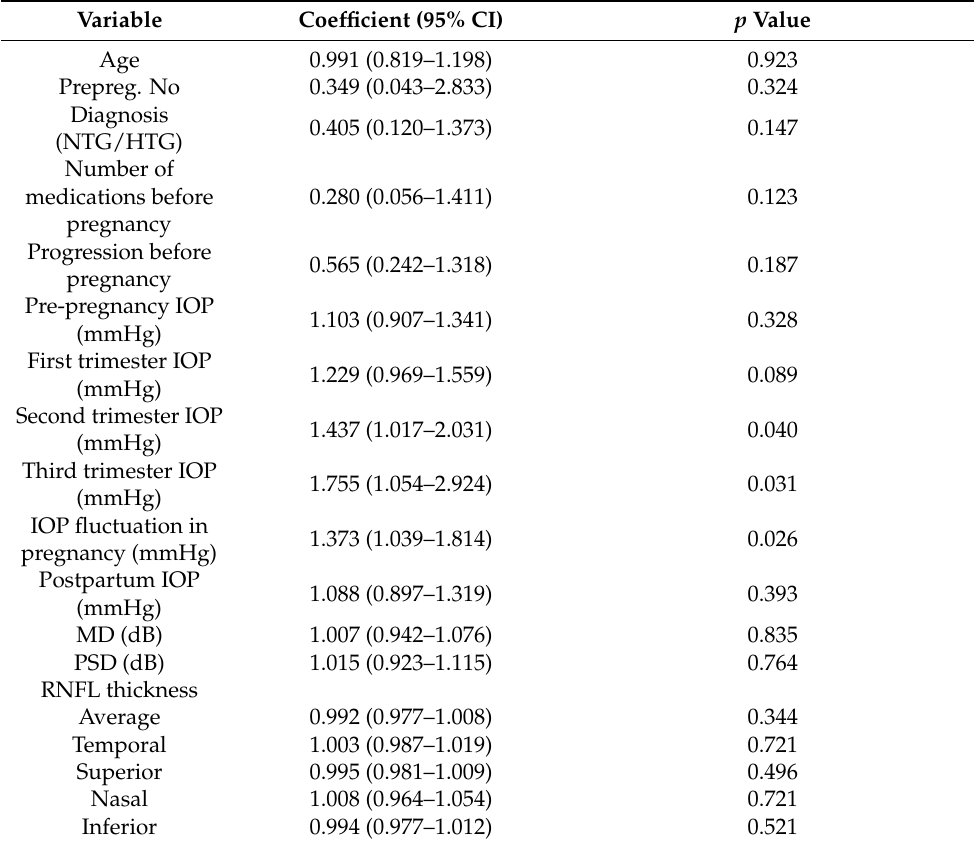
Table 3. Risk factors for glaucoma progression by univariate logistic regression